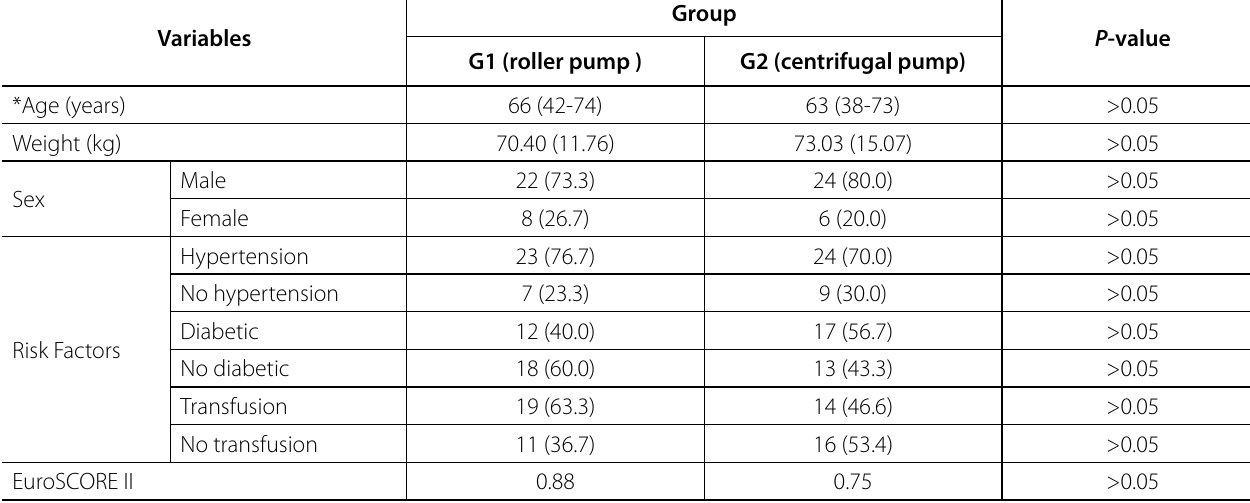
Table 1. Demographic characteristics of the sample, stratified by group.